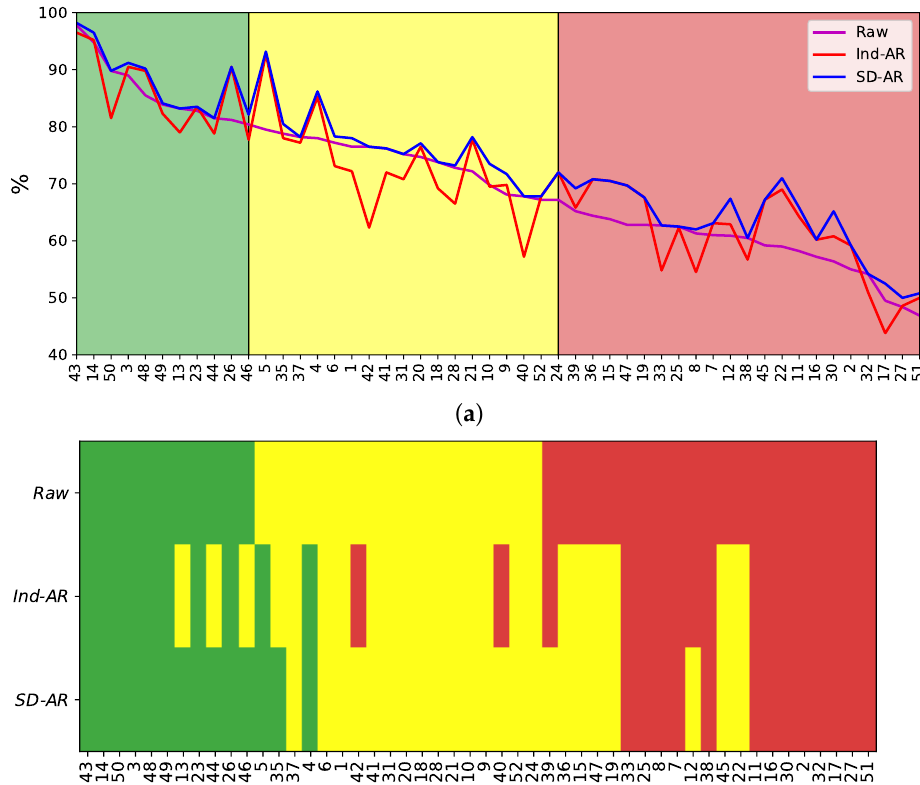
Figure 5. Clustering variability of individuals that belong to Group I (cells in green), Group II (yellow), and Group III (red), depending on the preprocessing strategy. ( a ) LDA-based Accuracy of MI tasks. ( b ) Resulting partitions of MI